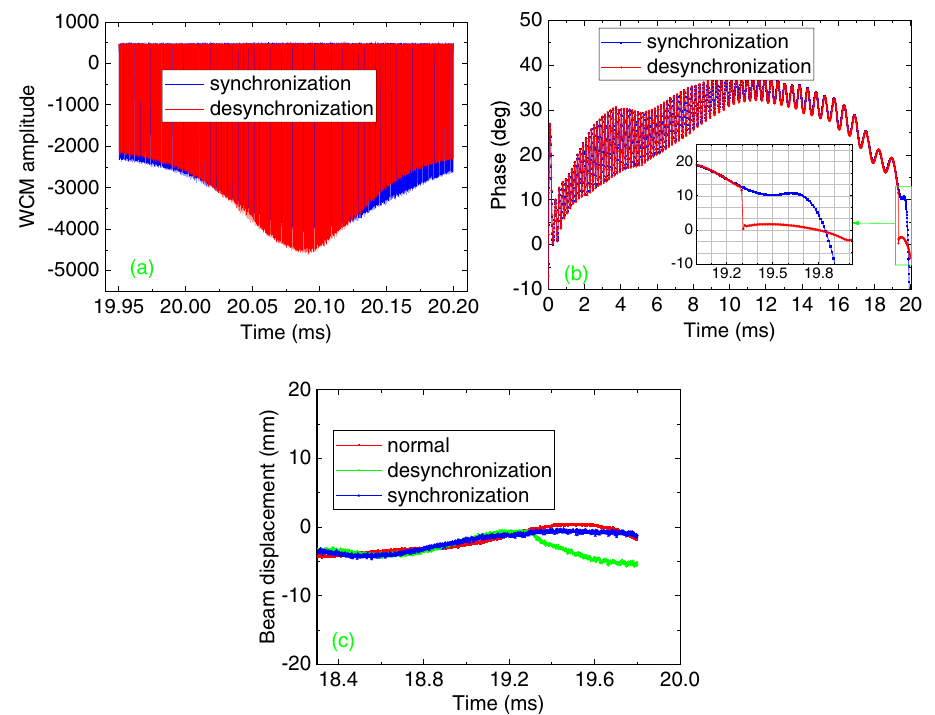
FIG. 13. Experimental verification of the controlled desynchronization from (a) the analysis of the amplitude of the WCM signal; (b) the FCT phase; (c) the BPM beam centroid. “ synchronization ” denotes that only the rf voltage pattern is applied to extract short bunches, without modification to the rf frequency and phase. Experimental conditions: beam power of 30 kW and chopping factor of 60% for (a) and (b); beam power of 50 kW and chopping factor of 41% for (c).